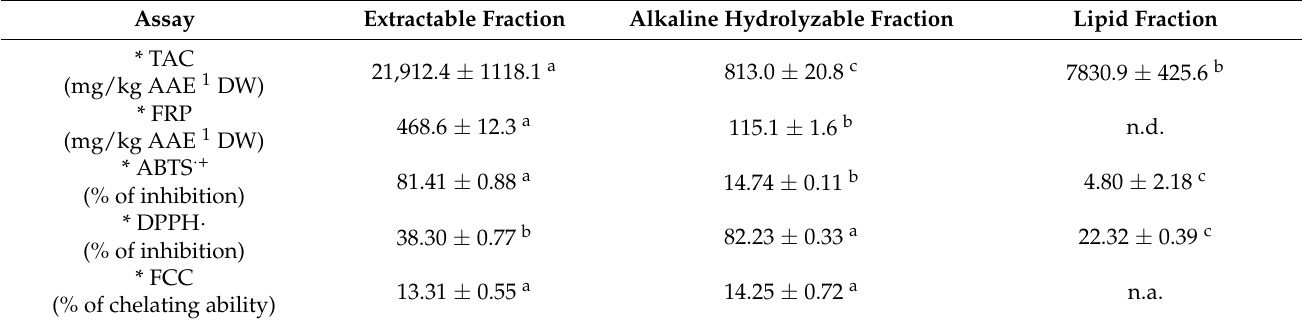
Table 4. Antioxidant properties of phenolic and lipid fractions of bee-collected artichoke pollen. Assay Extractable Fraction Alkaline Hydrolyzable Fraction Lipid